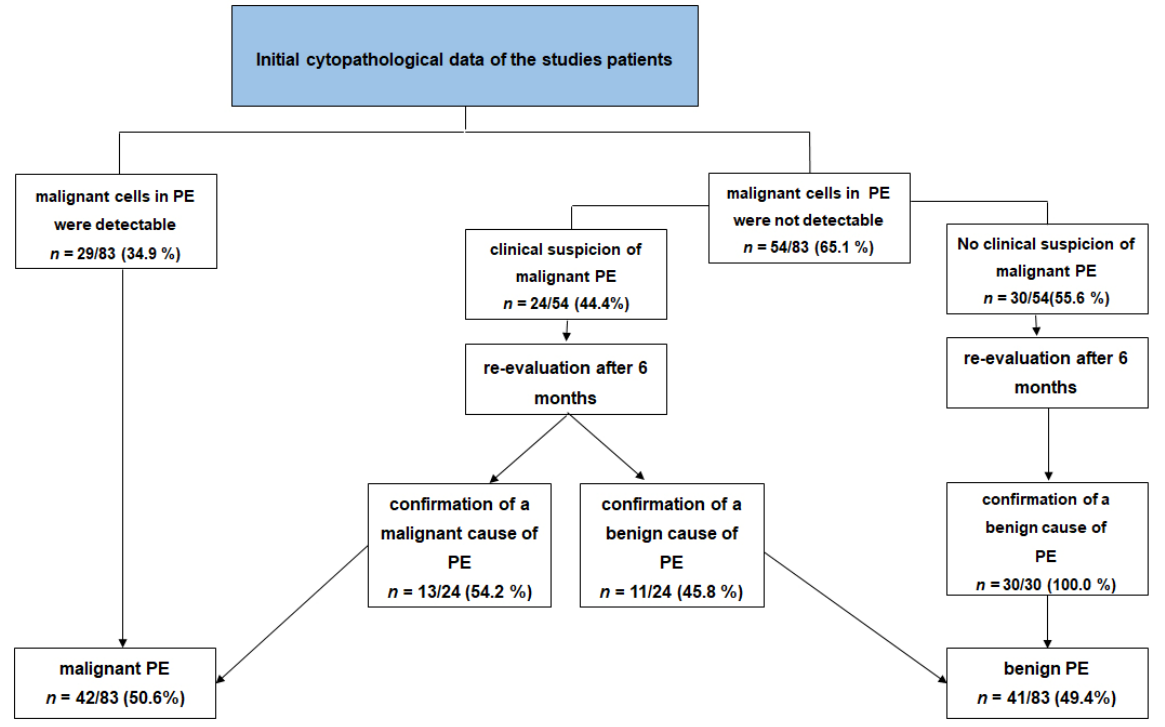
Figure 1. Work-up to the final diagnosis of PE in 83 patients with respect to the initial cytopathological results, clinical background, and follow-up.